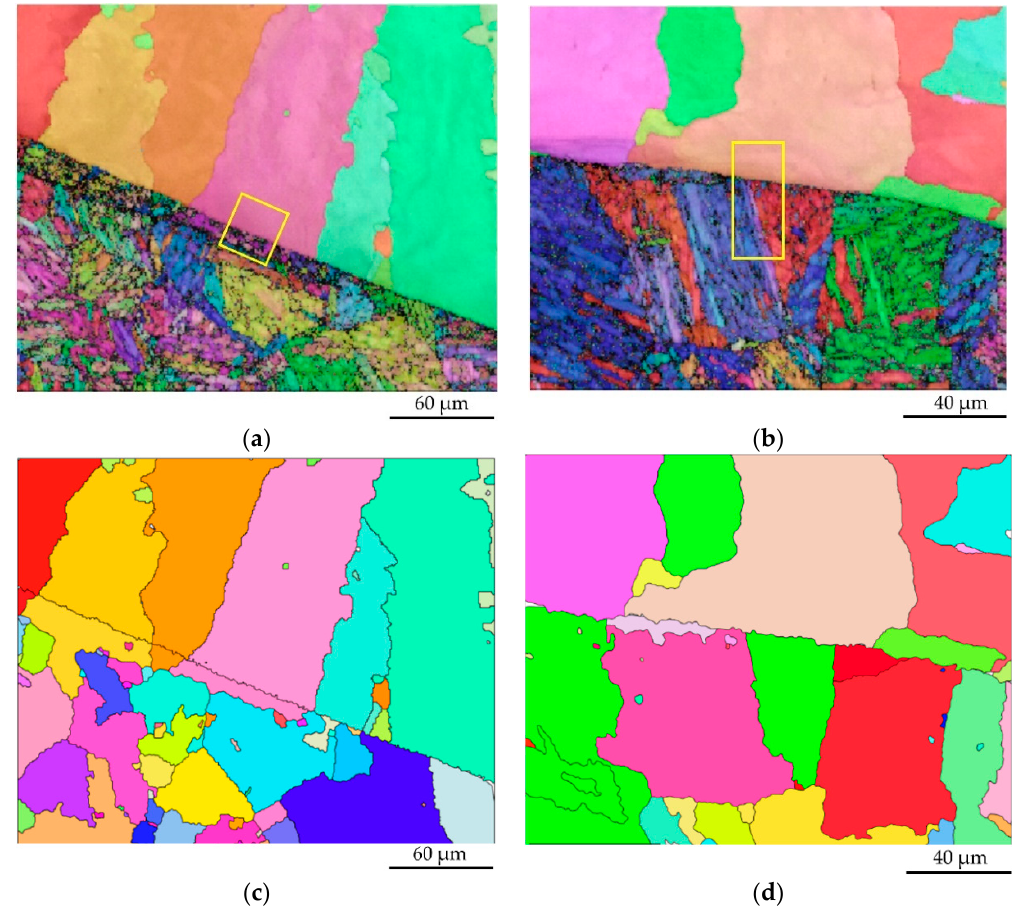
Figure 9. Electron backscatter diffraction maps of the transition zone of the substrate/clad: grains with boundary types I ( a ) and II ( b ). Reconstruction of the previous austenite of the coarse grain heat affected zone of the substrate in the region of grains with boundary type I and II, ( c ) and ( d ), respectively, by using the Nyyssönen algorithm [29]. Magnification: ( a , c ) 1000× and ( b , d ) 1500×. Work distance: ( a ) 17.7 mm and ( b ) 17.5 mm.